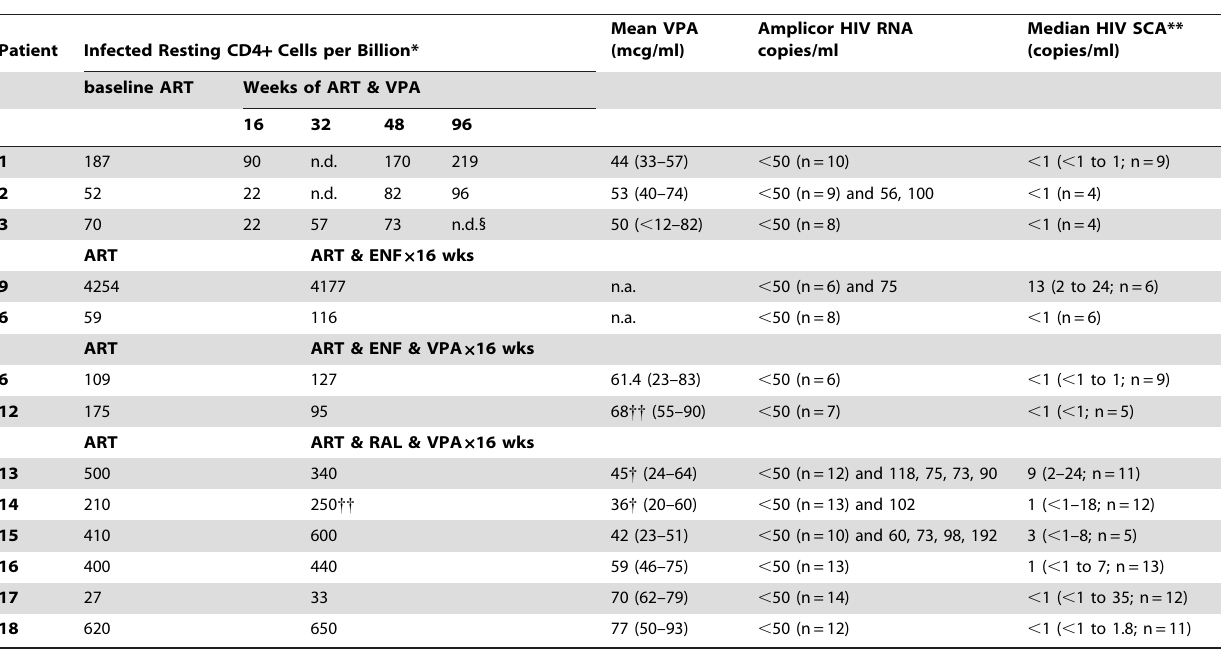
Table 1. Effect of VPA and intensified ART on resting cell infection and low-level viremia.